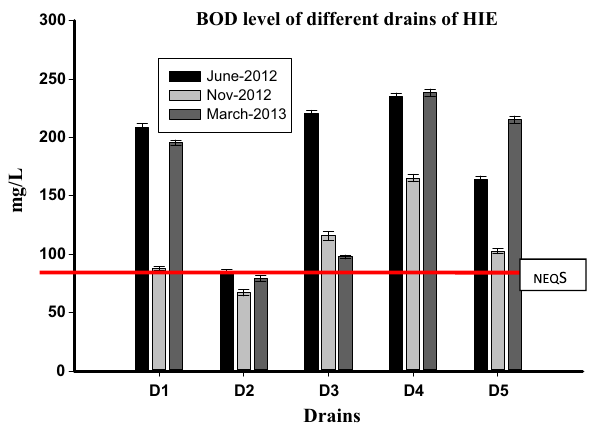
Fig. 4 NH 4 –N level of different drains of HIE